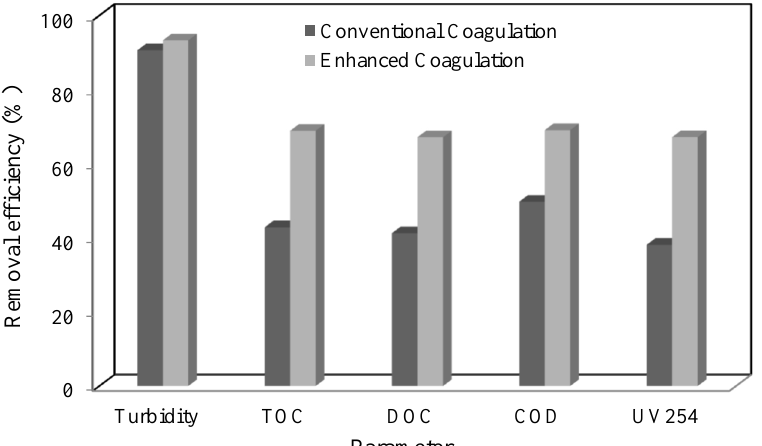
Fig. 5. Comparing FeCL 3 coagulant’s efficiency in removal of humic